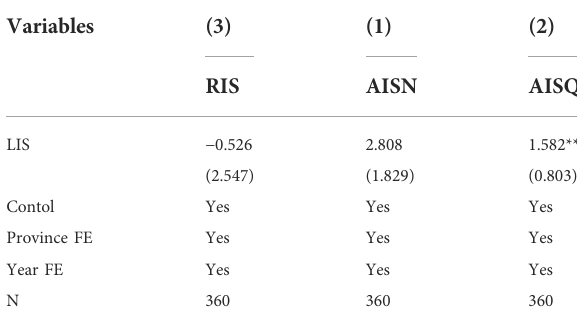
TABLE 7 In fl uence mechanism